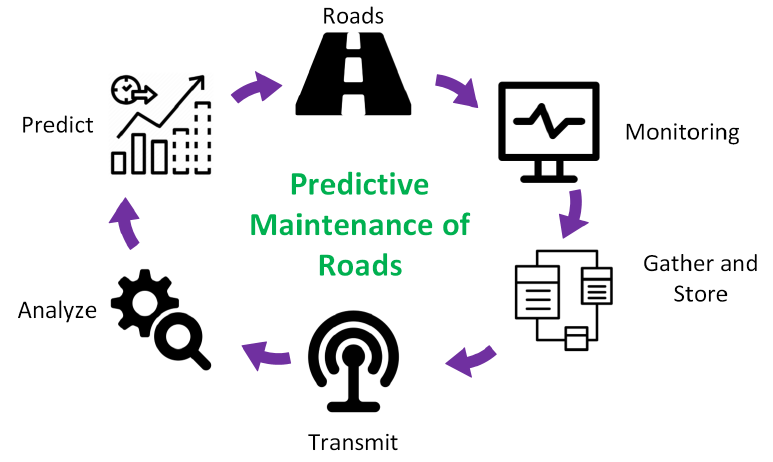
Figure 2. PdM-based framework for the maintenance of road